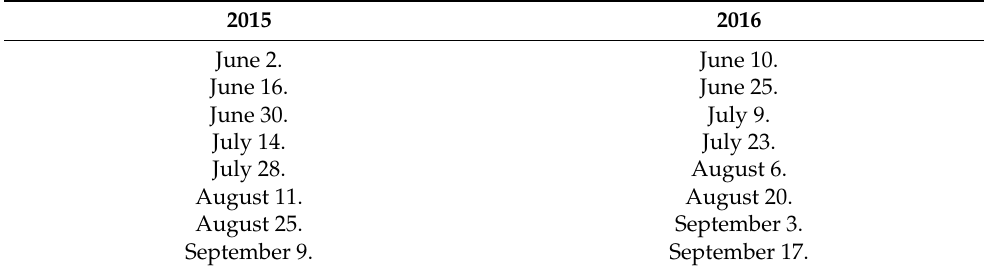
Table 3. Dates of developmental phase observations of Solidago spp. in the years of study.